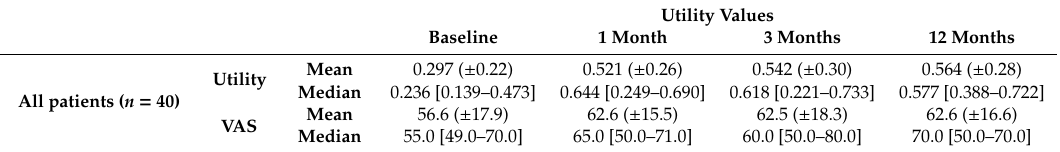
Table 5. Mean and median utility values ( ± SD; IQR) and VAS-score (0–100; ± SD; IQR) of the EQ-5D-3L of patients with complete follow-up, receiving HD-SCS. Abbreviations: HD-SCS: high dose Spinal Cord Stimulation, IQR: interquartile range, SD: standard deviation, VAS: Visual Analogue Scale. Utility Values Baseline 1 Month 3 Months 12